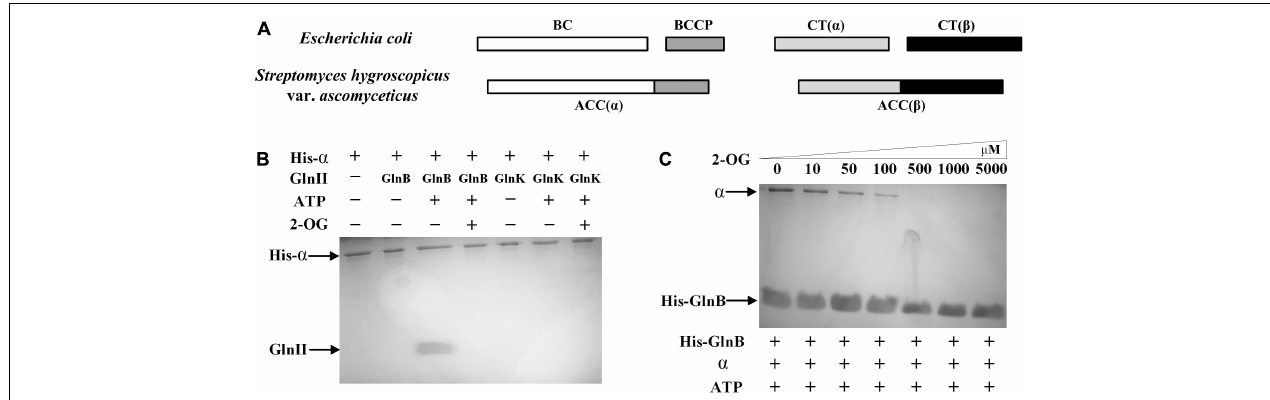
FIGURE 2 | Components of acetyl-CoA carboxylase (ACC) in Streptomyces hygroscopicus var. ascomyceticus and the interactions of the two PII proteins with α subunit of ACC. (A) Comparison of ACC composition between S. hygroscopicus var. ascomyceticus and Escherichia coli . The shaded boxes represent different functional units. The individual shaded boxes indicate different subunits. Connected shaded boxes indicate subunits that are fused into a single polypeptide chain. (B) Protein co-precipitation experiments to demonstrate the interaction between the PII proteins and the α subunit of ACC. The reactions were performed in buffer containing 2 mM 2-OG or 3.5 mM ATP. (C) The effect of 2-OG on the interaction between GlnB protein and the α subunit of ACC. The reactions were carried out in buffer containing different concentrations of 2-OG and 3.5 mM ATP. The blots on the gel map indicate the proteins eluted in the pull-down experiments. The slope above the blots indicates an increase in the gradient of 2-OG concentration from left to